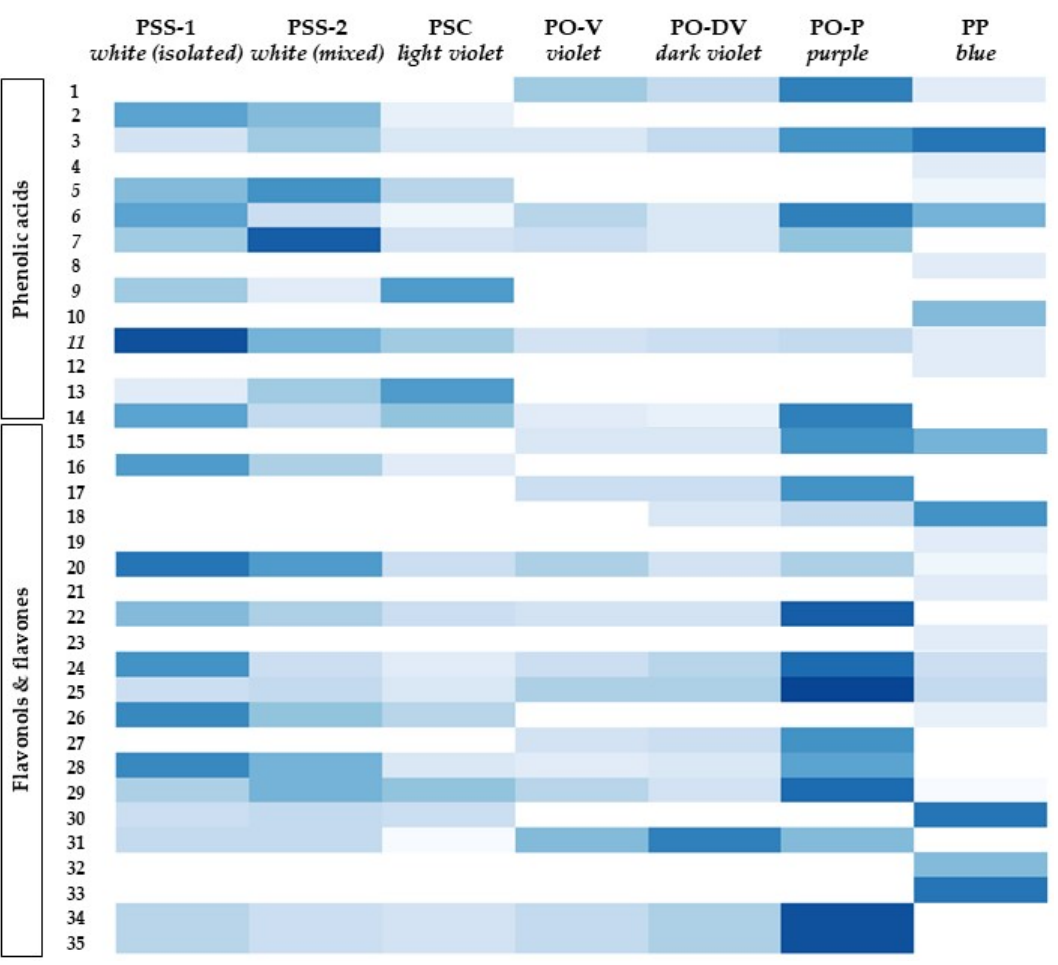
Figure 3. Distribution and content of phenolic compounds in Phyteuma . The color scale indicates the intensity of each compound amount between populations. Higher color intensity indicates higher amounts of each compound. PSS-1, P. spicatum ssp. spicatum populations growing alone; PSS-2, P. spicatum ssp. spicatum growing in sympatry with P. spicatum ssp. caeruleum ; PSC, P. spicatum ssp. caeruleum ; PO-V, P. ovatum populations with violet flowers; PO-DV, P. ovatum populations with dark violet flowers; PO-P, P. ovatum populations with purple flowers; PP, P. persicifolium